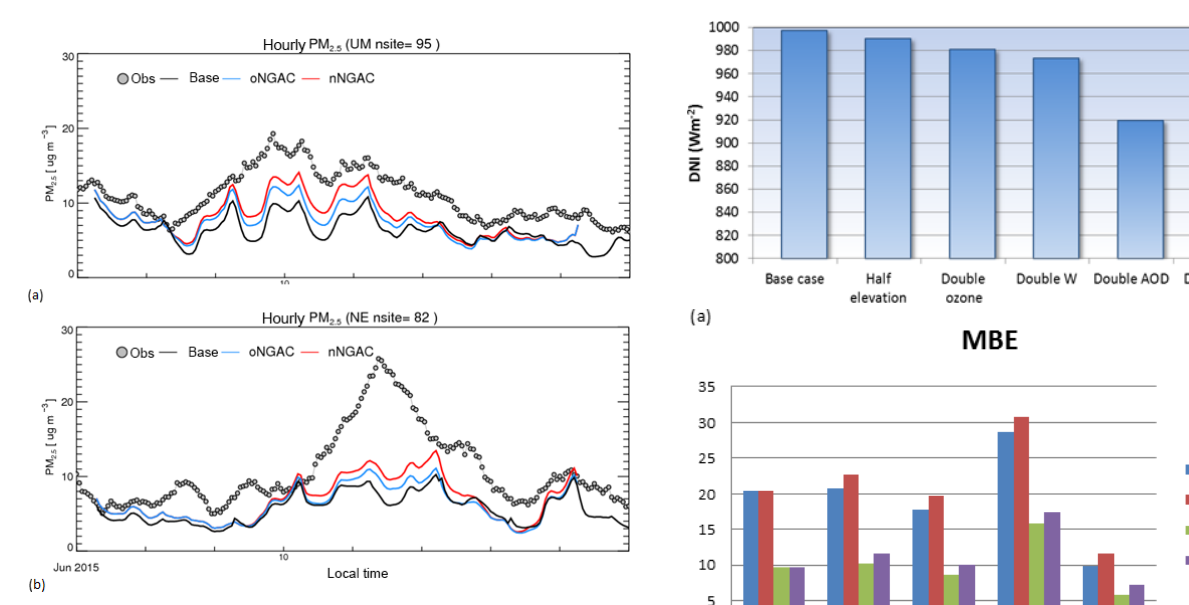
Figure 5. Surface PM 2 . 5 with frontal passages in the 9–12 June 2015 Canadian fire. Panel (a) is the averaged surface PM 2 . 5 from 95 sites in the middle of the United States from 7 to 15 June. Panel (b) is the averaged surface PM 2 . 5 from 82 sites in the northeast of United States. The line with circular dots is observations. The black line is the CMAQ forecast with climatology as a lateral boundary condition. The blue line is the CMAQ using operational NGAC dust-only forecast as a lateral boundary condition. The red line is the CMAQ forecast using an NGACv2 multispecies aerosol fore- cast.